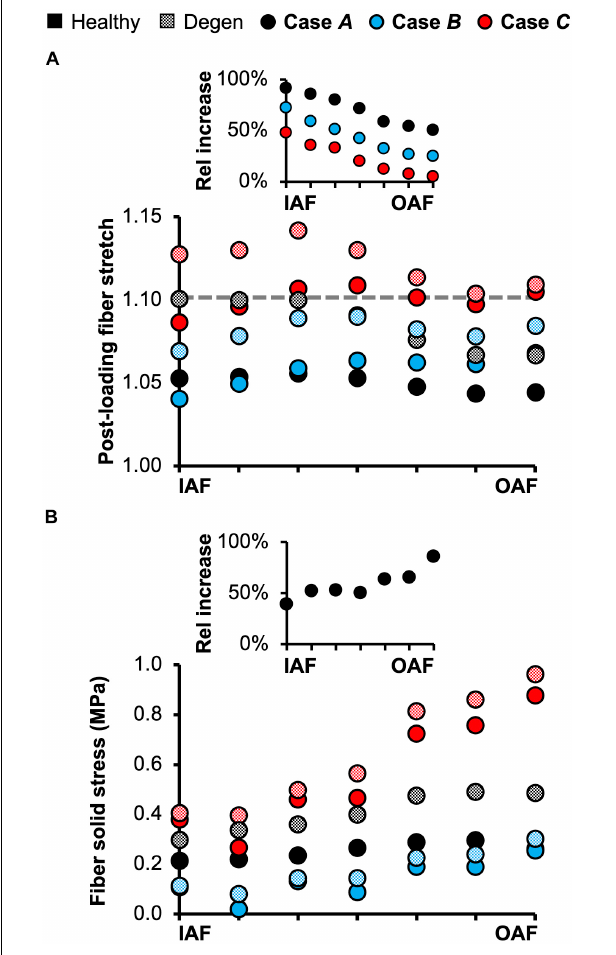
FIGURE 10 | (A) Model-predicted average annulus fibrosus (AF) post-loading fiber stretch along the disc radial direction from the inner AF (IAF) to outer AF (OAF) in healthy and degenerated (Degen) disc models. The gray horizontal dashed line highlights the fiber stretch threshold, above which the fibers have a more significant chance of failure based on previous experimental observations. The threshold value was determined based on data reported by Skaggs et al. (1994) and Isaacs et al. (2014). The inset presents the relative (Rel) percentage change in average fiber stretch with degeneration along the disc radial direction. (B) Model-predicted post-loading average AF solid stress along the disc radial direction from the IAF to OAF. The inset presents the relative increase in fiber solid stress with degeneration for Case A